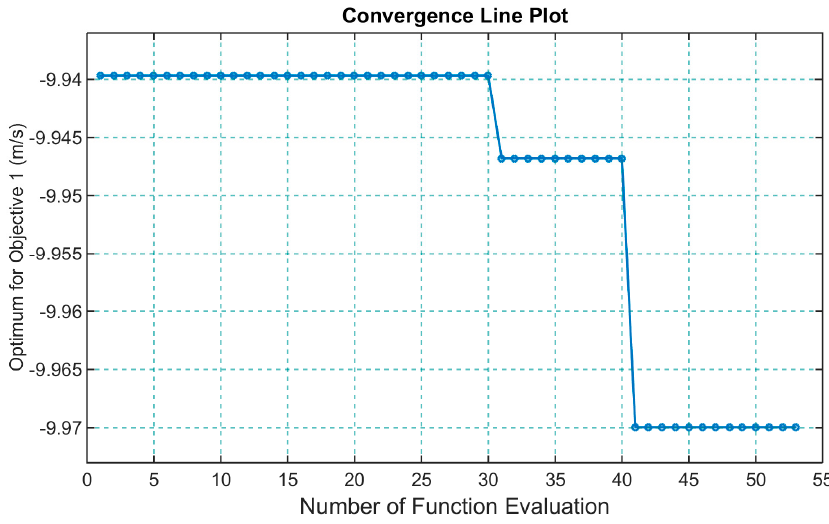
Figure 12. Convergence line plot of the Metamodel-Assisted Optimization (MMAO) optimization tool.